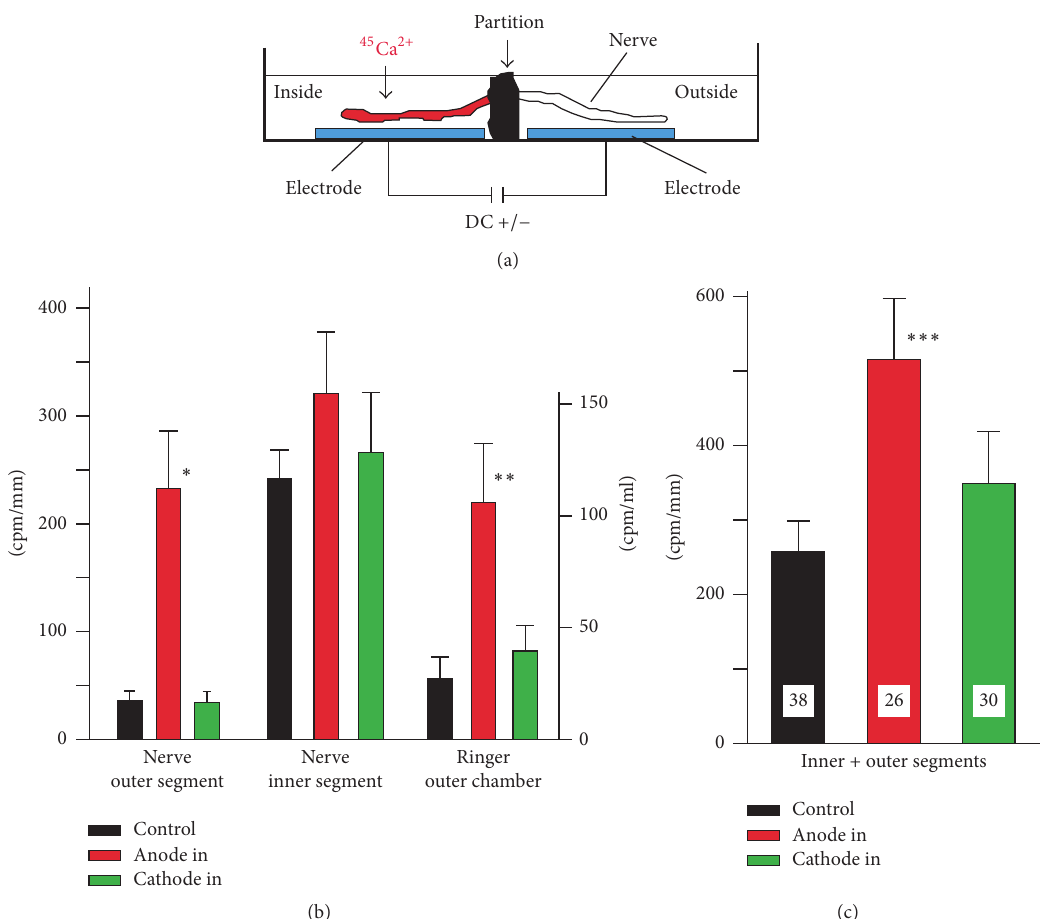
Figure 2: Theaccumulation of 45 Ca 2+ by theDC-stimulated sciaticnerve invitro. (a)An experimental setup. ThePetri dish(3 cm in diameter) was divided into two parts with partition made of hydrophobic petroleum jelly/silicone oil mixture. There was a stainless steel electrode placed at the bottom of each part (6 × 10mm). The segment of the sciatic nerve was extended through the partition. The only electrical connection between two parts of the Petri dish was through the sciatic nerve. The electrodes were connected to DC power supply delivering 0.1 mA for 3 󸀠 . The reference electrode was much closer (approximately 8–10-fold) than in in vivo experiments. Therefore, to compensate for the distance and equalize experimental conditions, the intensity of stimulation for these experiments was adjusted accordingly. 45 Ca 2+ was always added to the same part called “inner chamber.” (b) 45 Ca 2+ accumulation in the inner and outer segments exposed to either anodal or cathodal stimulation delivered to inner chamber. The anodal DC stimulation induced statistically significant increase in 45 Ca 2+ accumulation in the outer segment ( ∗ 𝑝 < 0.001 , Mann–Whitney U test) and in Ringer’s solution collected from outer chamber ( ∗∗ 𝑝 < 0.03 , Mann–Whitney U test). The anodal and cathodal stimulations induced a similar increase in the segment of the nerve located in the inner chamber, although those increases were not statistically significant. Note the increase in the concentration of 45 Ca 2+ in the outer chamber (right side of Figure 1(b)). This diagram has two separate scales to express the amount of 45 Ca 2+ in the nerve (cpm/mm, left scale) and the concentration of 45 Ca 2+ in the Ringers of the outer chamber (cpm/ml, right scale). (c) The total accumulation of 45 Ca 2+ in the inner and outer chambers; ∗∗∗ 𝑝 < 0.001 as compared